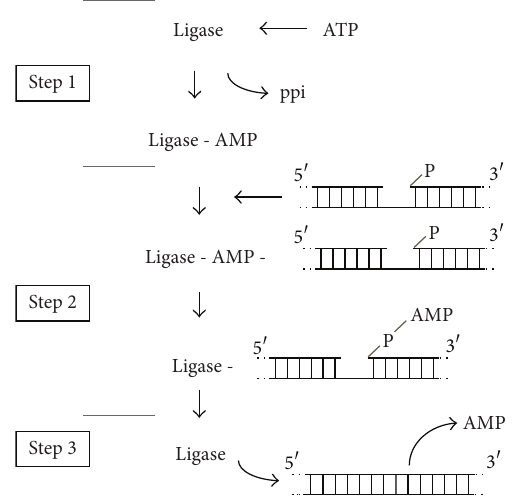
Figure 1: Schematic diagram of the three-step reaction catalyzed by ATP-dependent DNA ligases. The three-step reaction catalyzed by DNA ligase (Ligase) results in the serial transfer of AMP (adenosine 5 󸀠 -monophosphate)toanactivesitelysine(step1)andthentothe5 󸀠 - PO 4 end of DNA (step 2). During step 3, the 3 󸀠 -OH end of a second DNA strand attacks the 5 󸀠 -PO 4 , to release AMP and generate the ligated DNA